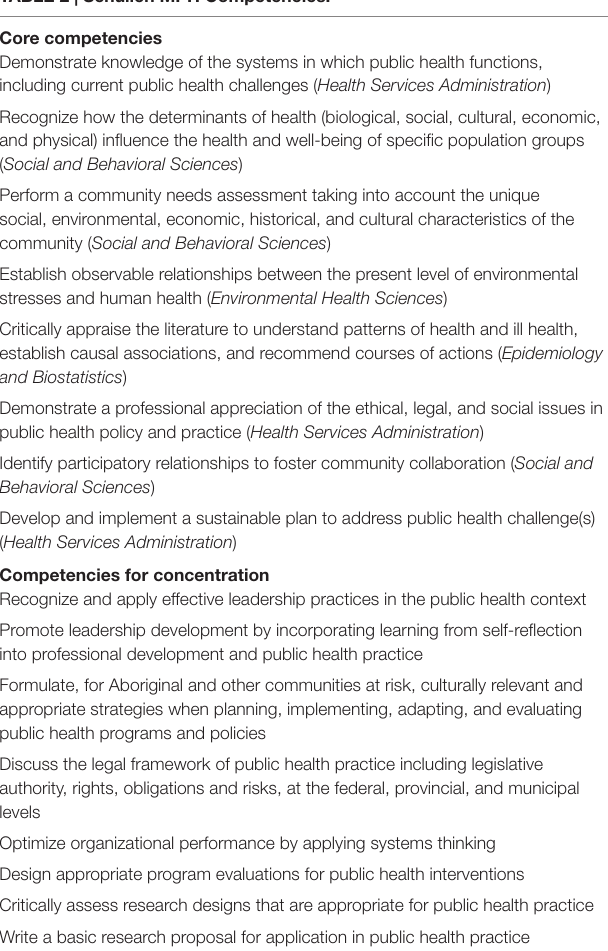
taBle 2 | schulich mPH